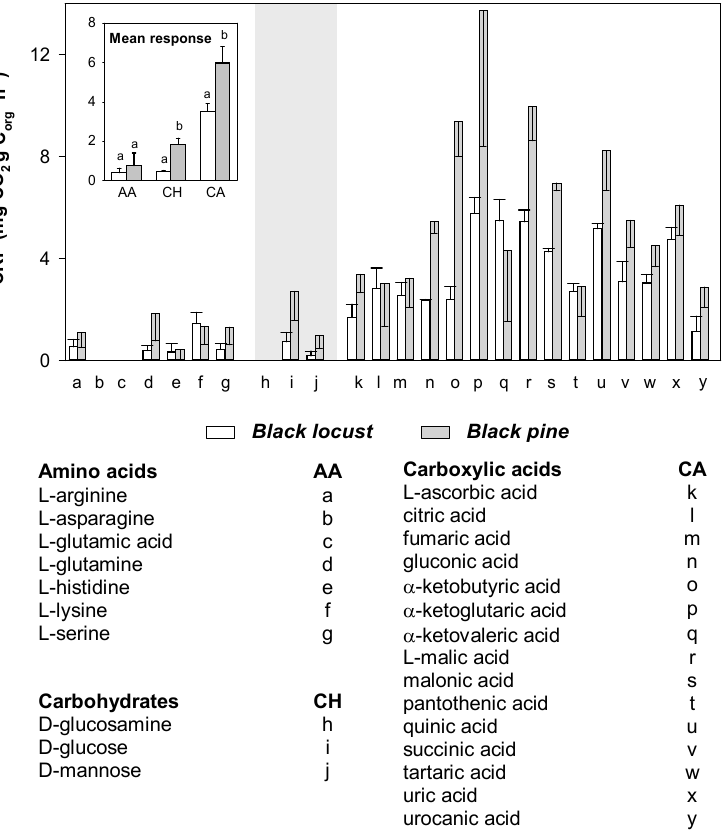
Figure 2. Catabolic Response Profile (CPR) of mineral soil from a black locust and a black pine stand. CRP was measured in soil samples (0–5 cm depth) amended with 25 low ‐ molecular simple organic substrates in the paired stands (see legend). The mean response for type of substrate (AA: amino acids; CH: carbohydrates; CA: carboxylic acids) is shown in the inner panel. Different lowercase letters indicate statistically significant differences ( t ‐ test, p < 0.05) between stands.